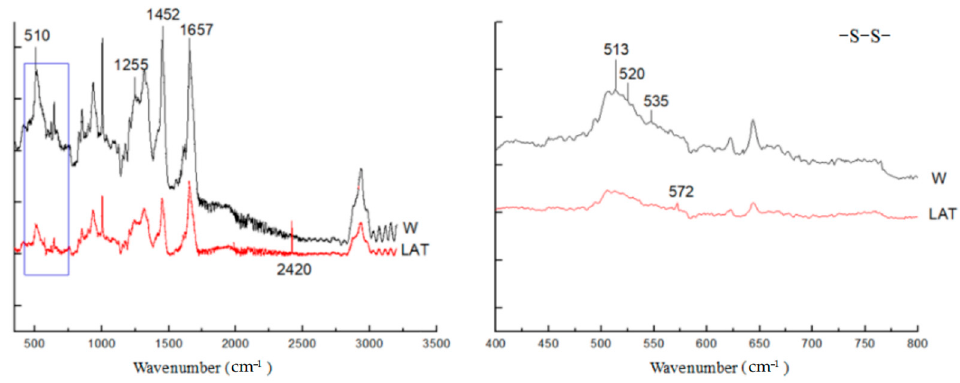
Figure 5. Raman spectra of wool fiber.